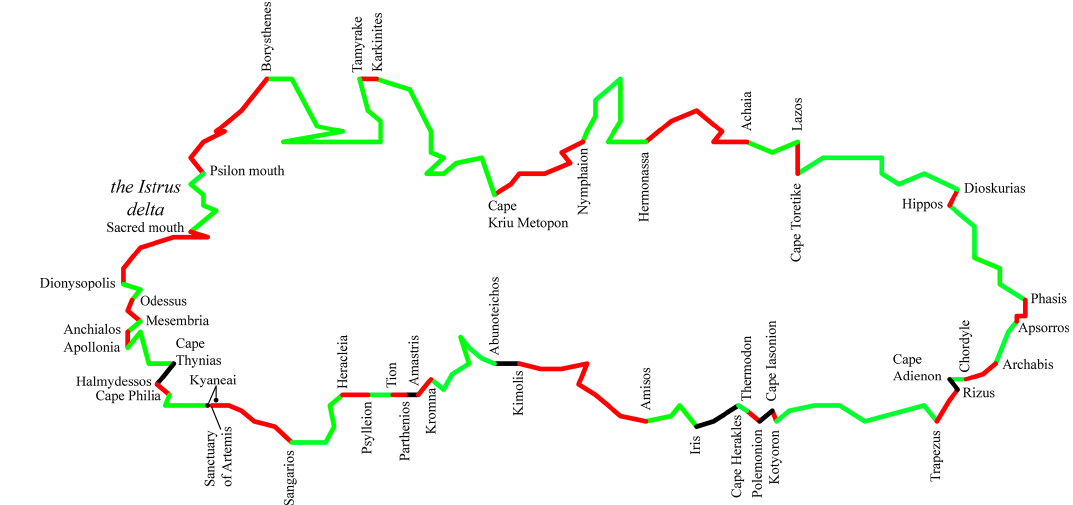
Figure 5. The segments of the Pontus coastline on Ptolemy’s map that are stretched (green) or contracted (red) by more than 20 stades relative to the corresponding distances reported by Pseudo-Arrian.